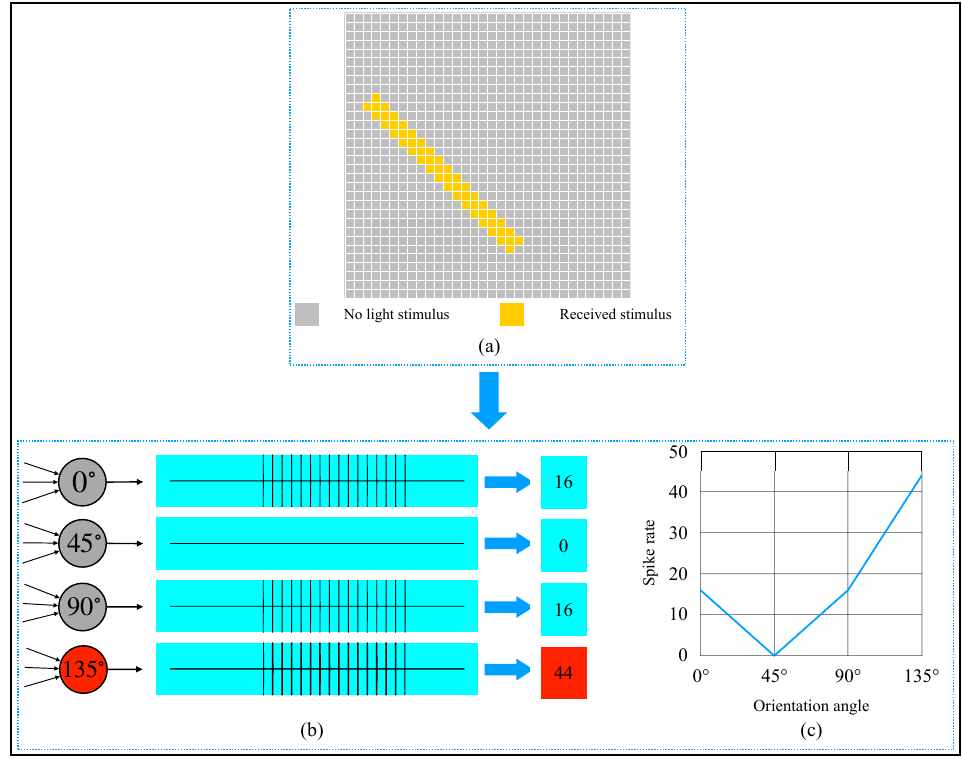
Figure 11. Computer simulation results of orientation detection on an object with a 135 ◦ orientation angle. ( a ) Object. ( b ) Spike records. ( c ) Spike rate curve of four types of complex